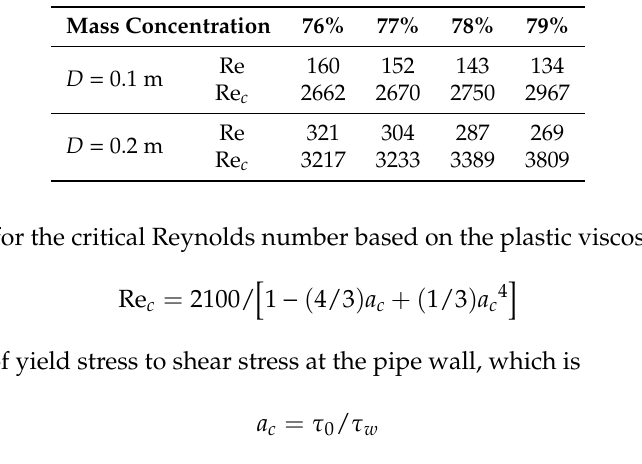
Table 4. Reynolds number and critical Reynolds number of the